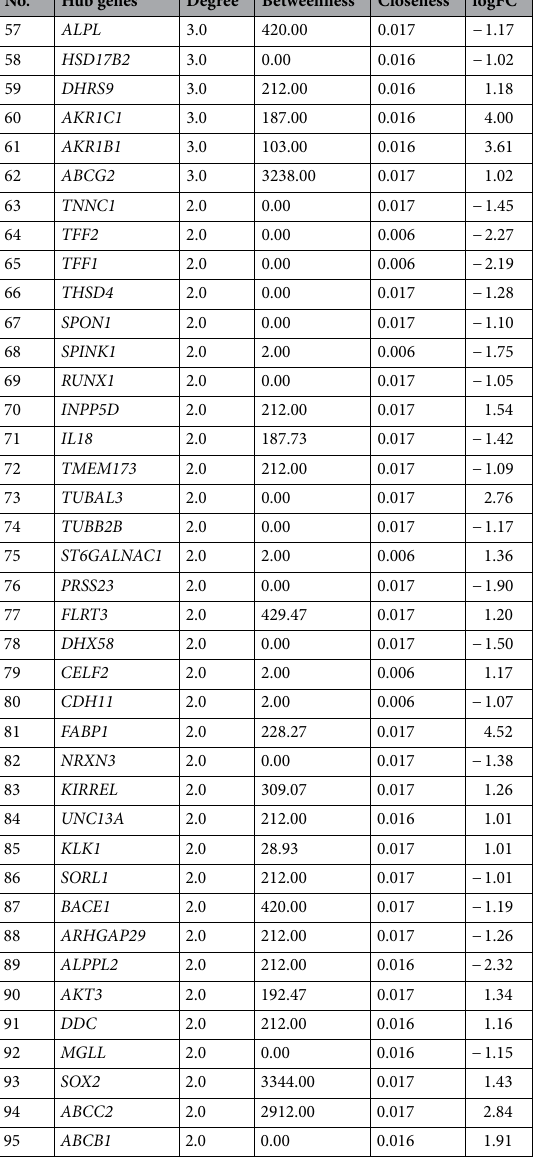
Table 1. The Rank of hub genes. Hub genes are defined as which DEGs had interactions (Degree ≥ 2) in the protein–protein interaction (PPI)